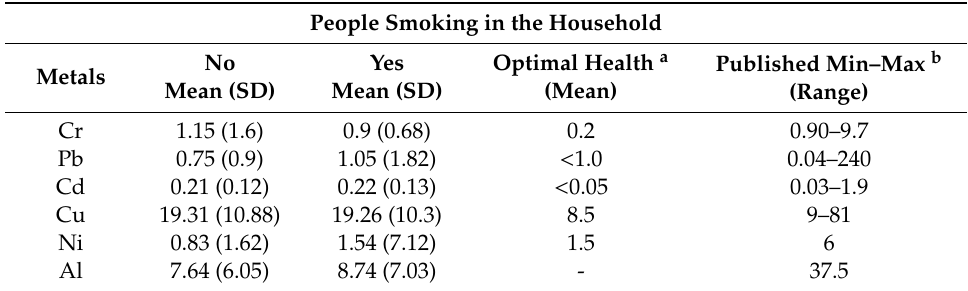
Table 3. Comparison of toenail heavy metals ( µ g / g) with recognized published values. People Smoking in the Household